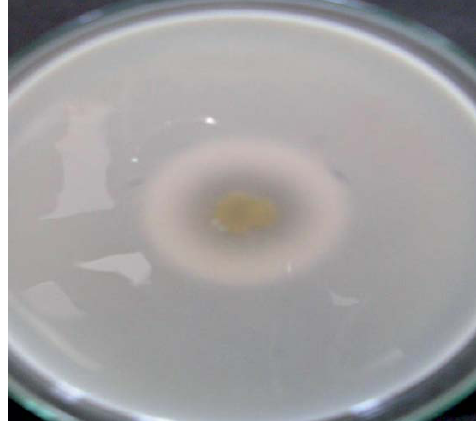
Fig. 1. Primary screening of thermophilic enzyme producing bacteria